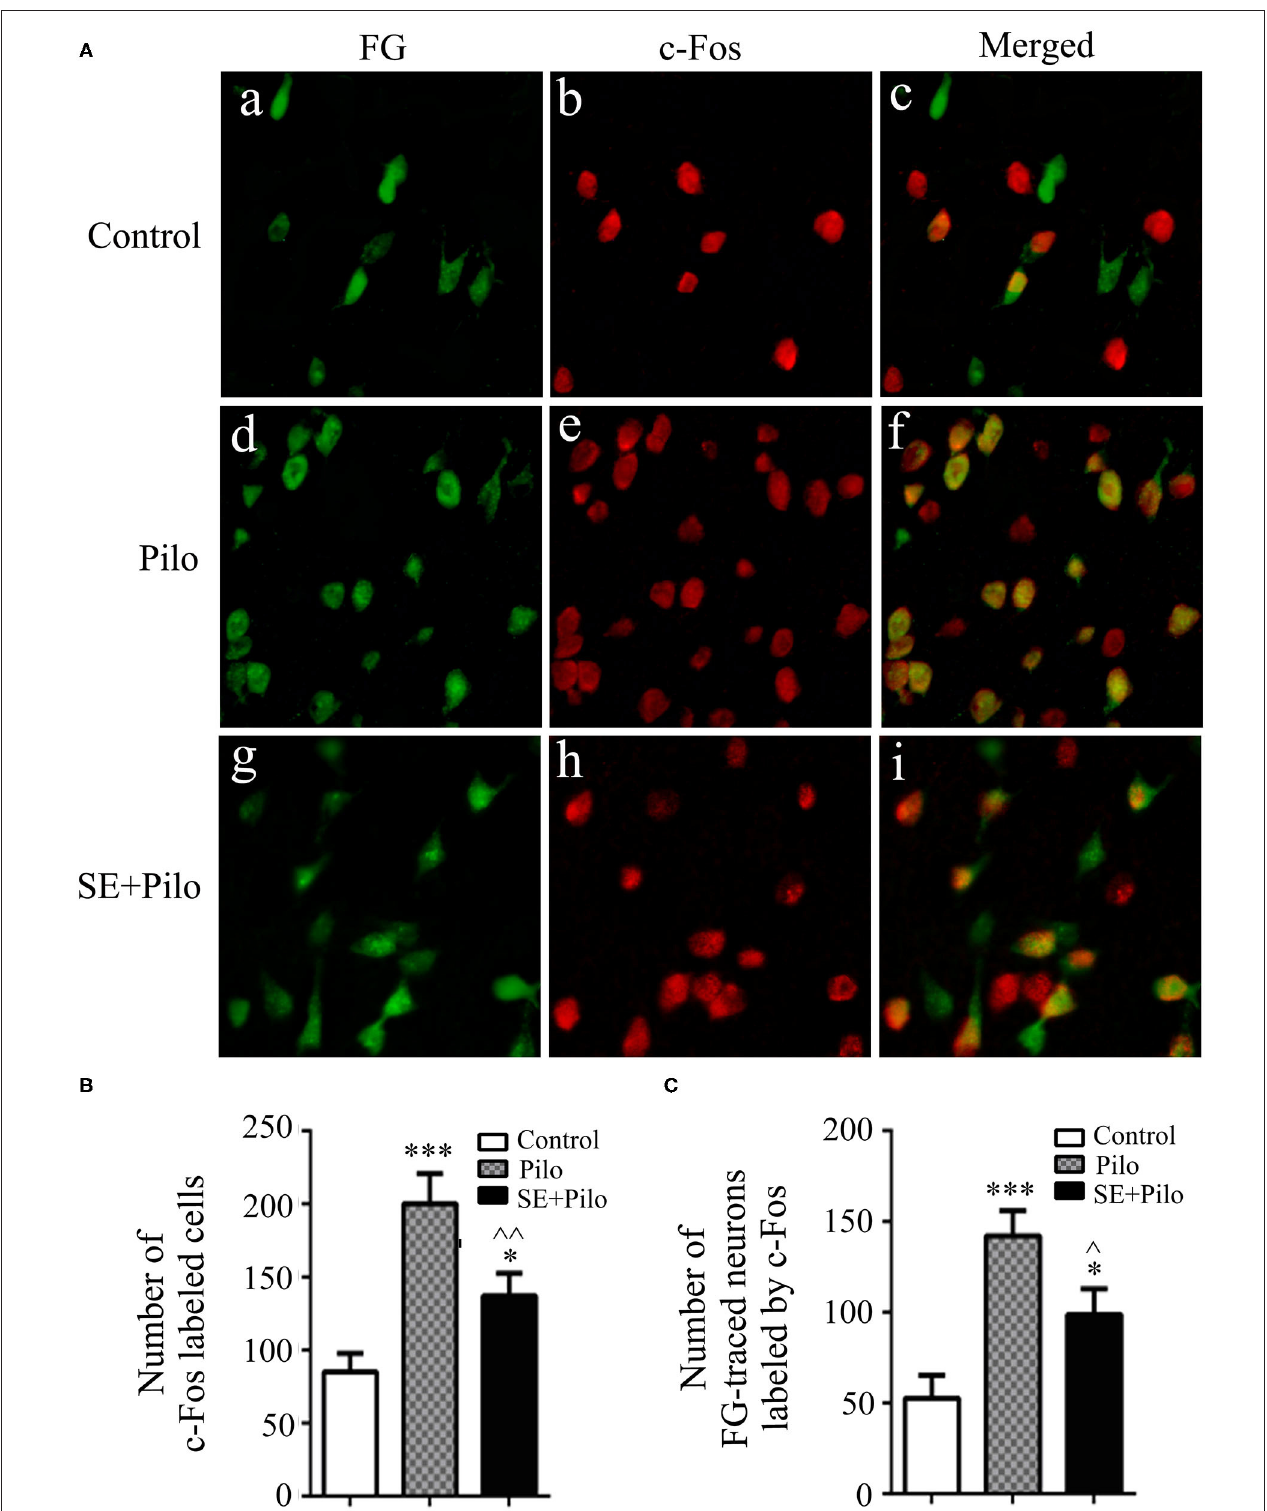
FIGURE 5 | Neuronal activation induced by seizure stimulation in vlPAG is attenuated in chronic epilepsy. Coronal sections were immunostained for c-Fos (red) and retrogradely traced with FG (green) (A) The mean number of c-Fos immunoreactive cells after a seizure stimulation either in naïve rats (meshy bar) or in